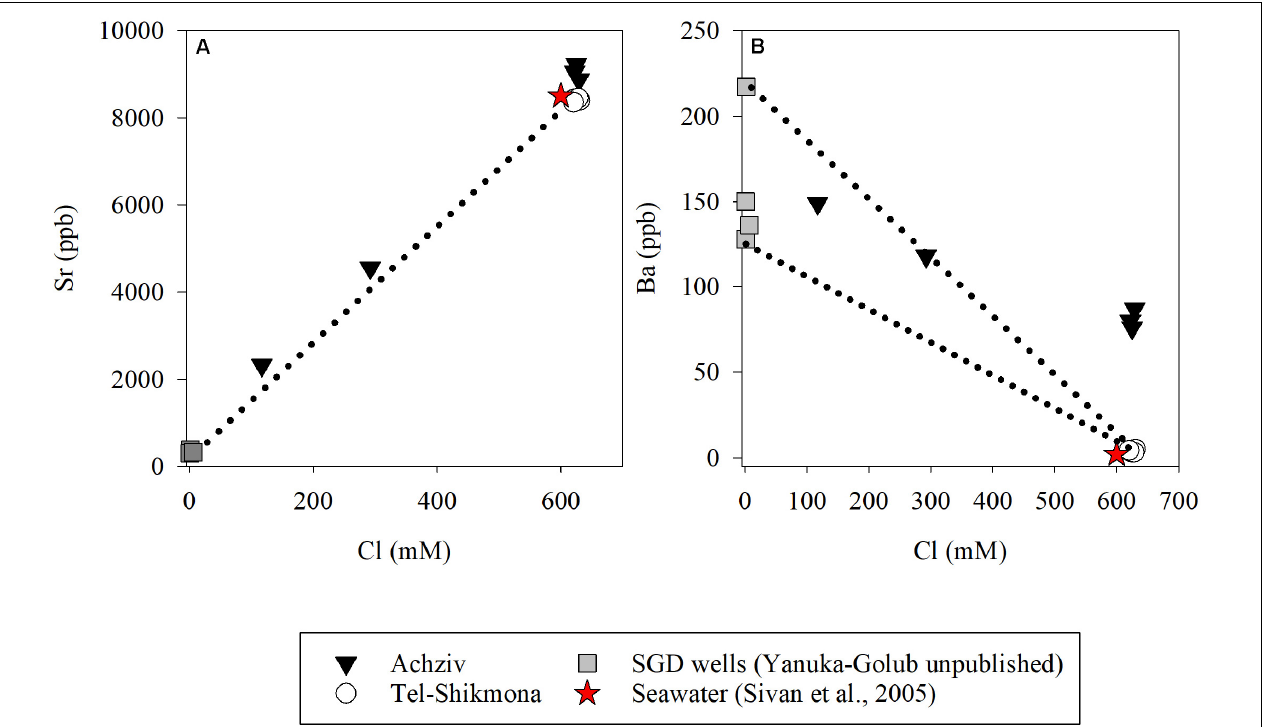
FIGURE 4 | Concentrations of Sr (A) and Ba (B) vs. Cl in Achziv (black triangle) and Tel-Shikmona (while circle). Gray squares show values measured in SGD wells near Achziv (Yanuka-Golub, unpublished) and the red star indicate a seawater mean value based on Sivan et al. (2005) at the Israeli coast. Dash lines indicates the freshwater-seawater mixing line (Sivan et al.,